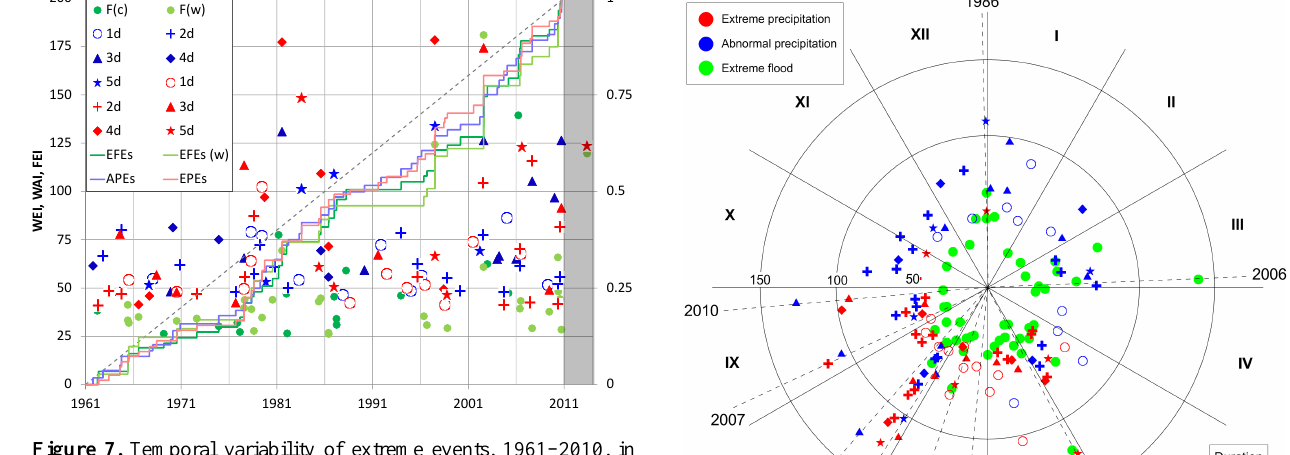
Figure 7. Temporal variability of extreme events, 1961–2010, in the Czech Republic. The red, blue, dark green, and light green sym- bols denote EPEs, APEs, EFEs during colder half of the year (ND- JFMA), and EFEs during warmer half of the year (MJJASO), re- spectively. The symbol shapes denote the duration (no. of days) of EPEs and APEs. The curves express relative cumulative values (right axis) of the WEI, the WAI, and the FEI (dark green denotes all seasons, light green denotes warmer half-years only). Figure 8. Seasonal distribution of extreme events in the Czech Re-